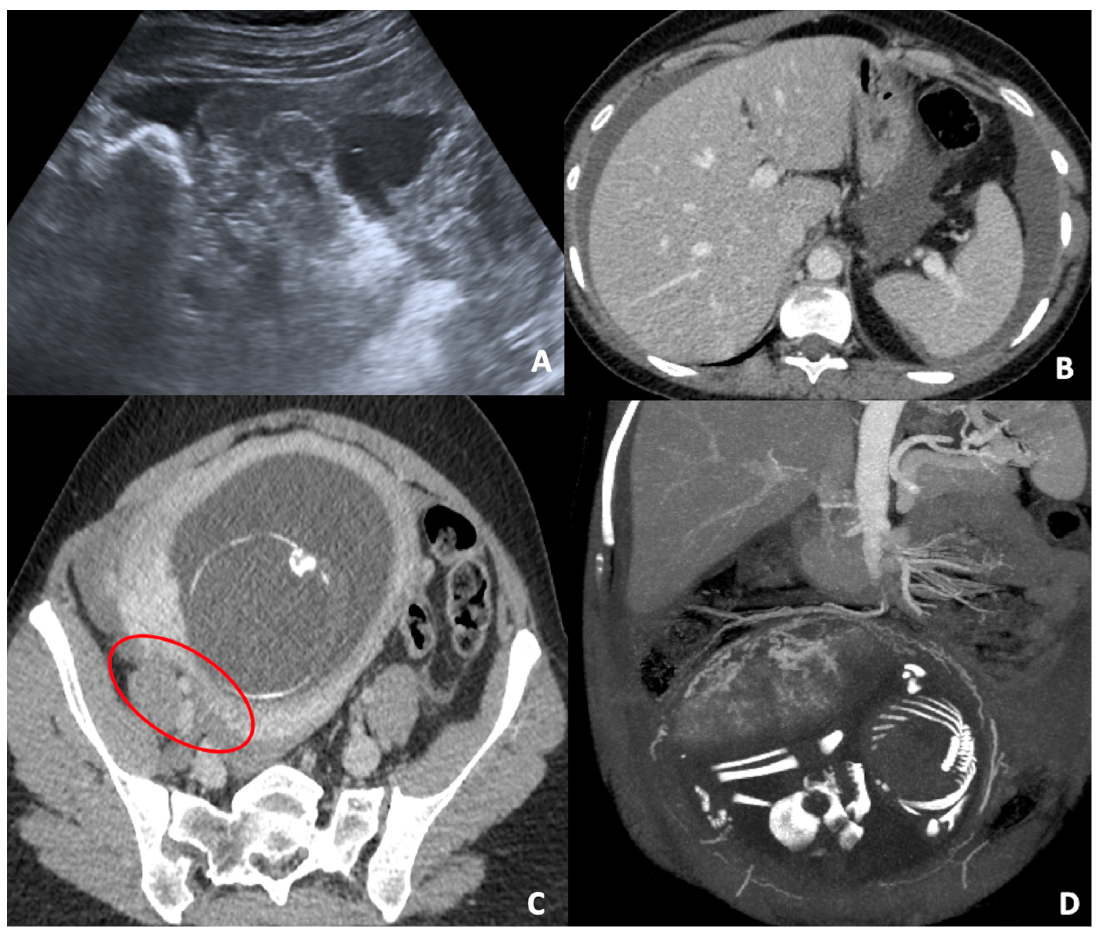
Figure 4. ( A ) Pelvic US scan of free inhomogeneous fluid in the pouch of Douglas compatible with hemoperitoneum; the uterus is enlarged and inhomogeneous with apparent wall defect. ( B , C ) CT axial images of the same patient show conspicuous hemoperitoneum; the gravid uterus is characterized by a severe thickness wall reduction (red circle), which corresponds to uterine tear. ( D ) CT coronal post-processed image (MIP) in venous phase clarifies the uterine vascularization and bleeding site.